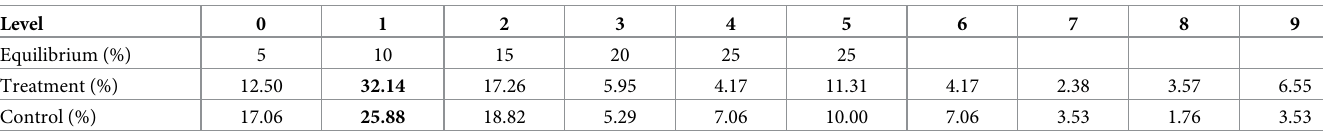
Table 3. Distribution of level-k